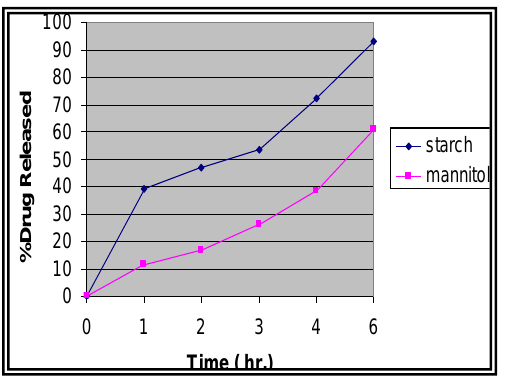
Figure 2 : Effect of Eudragit RS PM concentration on the percent released of nicotine at pH 6.8 and 37 o